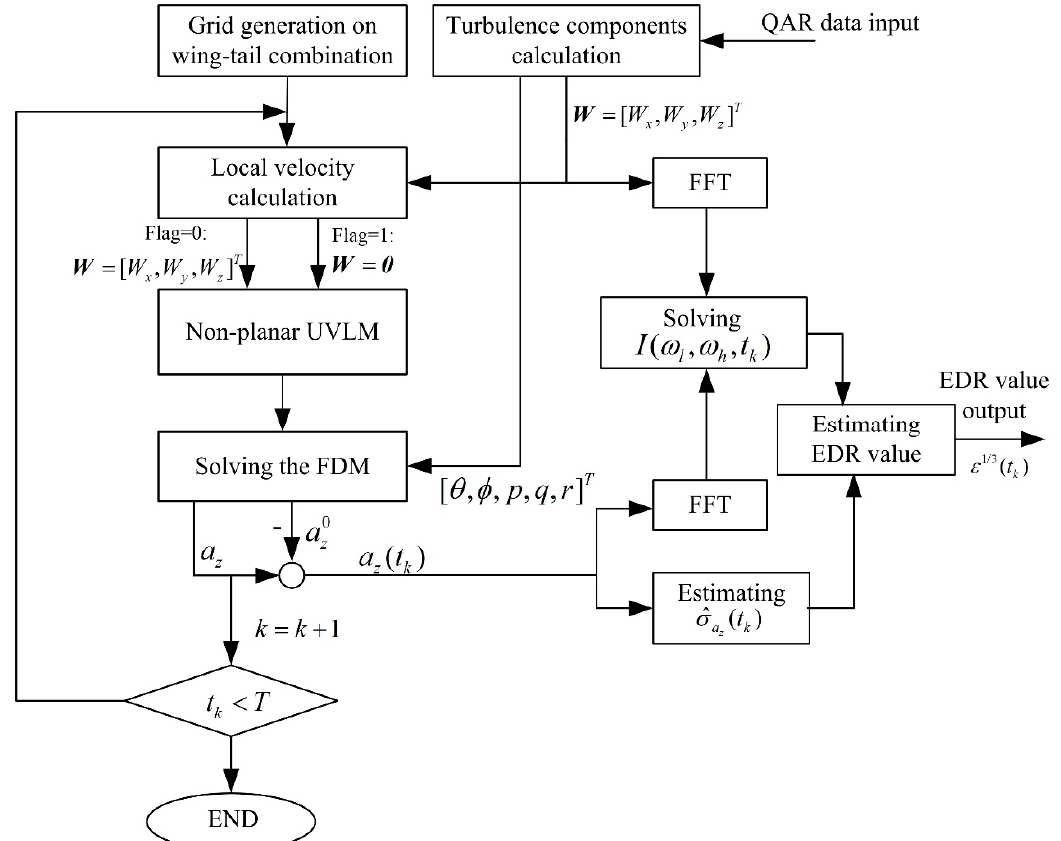
Figure 5. Algorithm flow of the new acceleration-based EDR estimation.